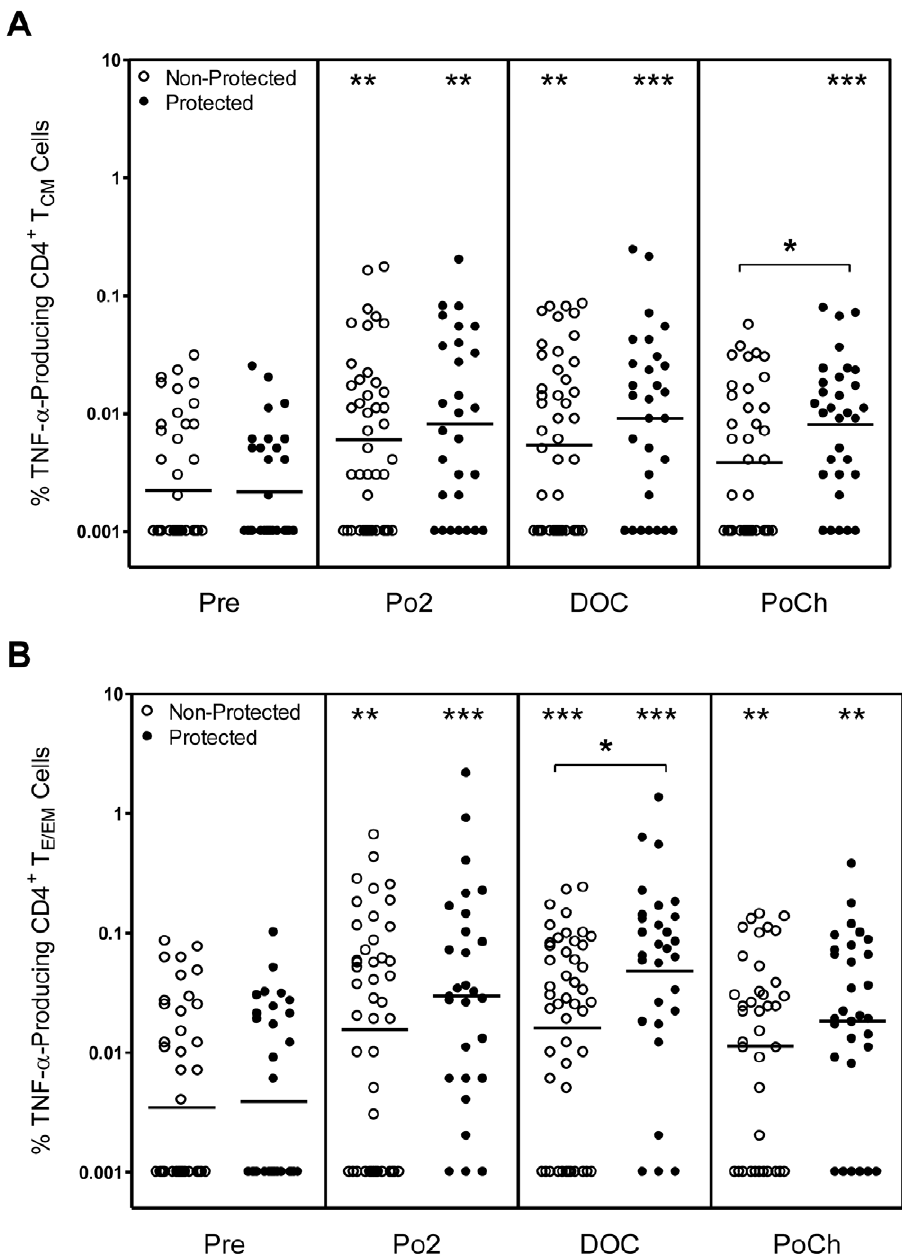
Figure 4. Frequency of CD4 + T CM and T E/EM cells producing TNF- a upon recall with CSP peptides. PBMC were obtained at the indicated time points from RTS,S-immunized subjects and were incubated as described in Fig. 3 with CSP peptides as described in Methods. Cells were then analyzed as described in the legend to Fig. 1. The values are plotted as [A] the % TNF- a -producing CD4 + T CM cells and [B] the % TNF- a -producing CD4 + T E/EM cells for protected (closed symbol) and non-protected (open symbol) subjects. Statistically significant differences between pre-immune and post-vaccination time points are indicated at the top of the graph. Statistically significant differences between values for protected and non- protected subjects are as indicated within the body of the graph. *p , 0.05; **p , 0.01; ***p , 0.001. doi:10.1371/journal.pone.0020775.g004 CD4 + T E/EM and T CM cells. The results (Fig. 7) show statistically Litjens et al [21] recently demonstrated a correlation between HBsAg-specific IL-2-producing memory T cells and the genera- significant correlations between the frequency of IL-2 producing tion of IgG-secreting plasma cells. To investigate if the level of CD4 + T cells and Ab responses for T E/EM Po2 (Rs =0.26; CSP R region-specific B cell responses were associated with the p = 0.03) and DOC (Rs =0.27; p= 0.02) and for T CM Po2 magnitude of RTS,S-induced IL-2 + CD4 + T cells, we performed (Rs= 0.35; p = 0.003). There was also, albeit weaker, correlation statistical calculations using Spearman’s regression analysis that between the frequency of IL-2 + TNF- a + CD4 T cells and Ab integrates the levels of CSP R region-specific serum Ab of each production (data not shown) but no correlation was observed volunteer with the corresponding frequency of IL-2 producing between Ab levels and total TNF- a + CD4 + T cells.